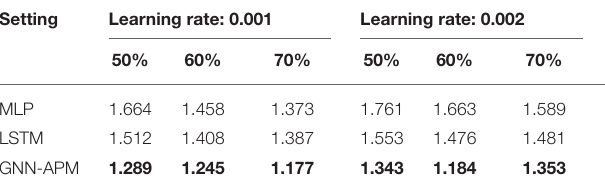
TABLE 2 | Root mean squared error (RMSE) results when the proportion of training data ranges from 50 to 70% and the learning rate ranges from 0.001 to